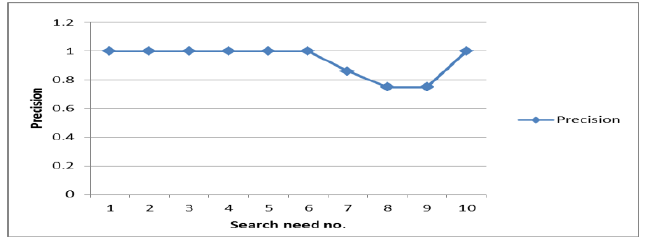
Fig. 11. Precision line graph of